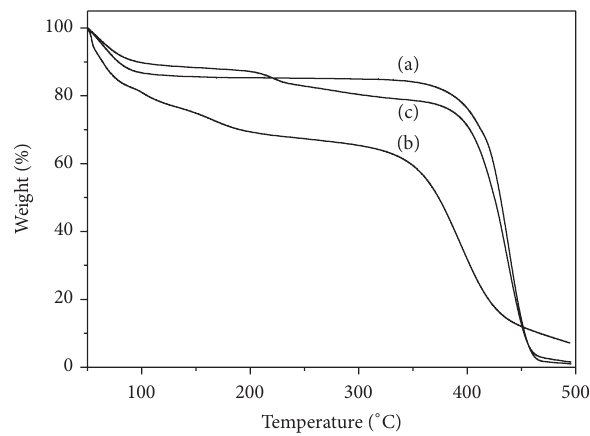
Table 1: Characterization data of PVPP, PVPP-BS, and [ PVPP-